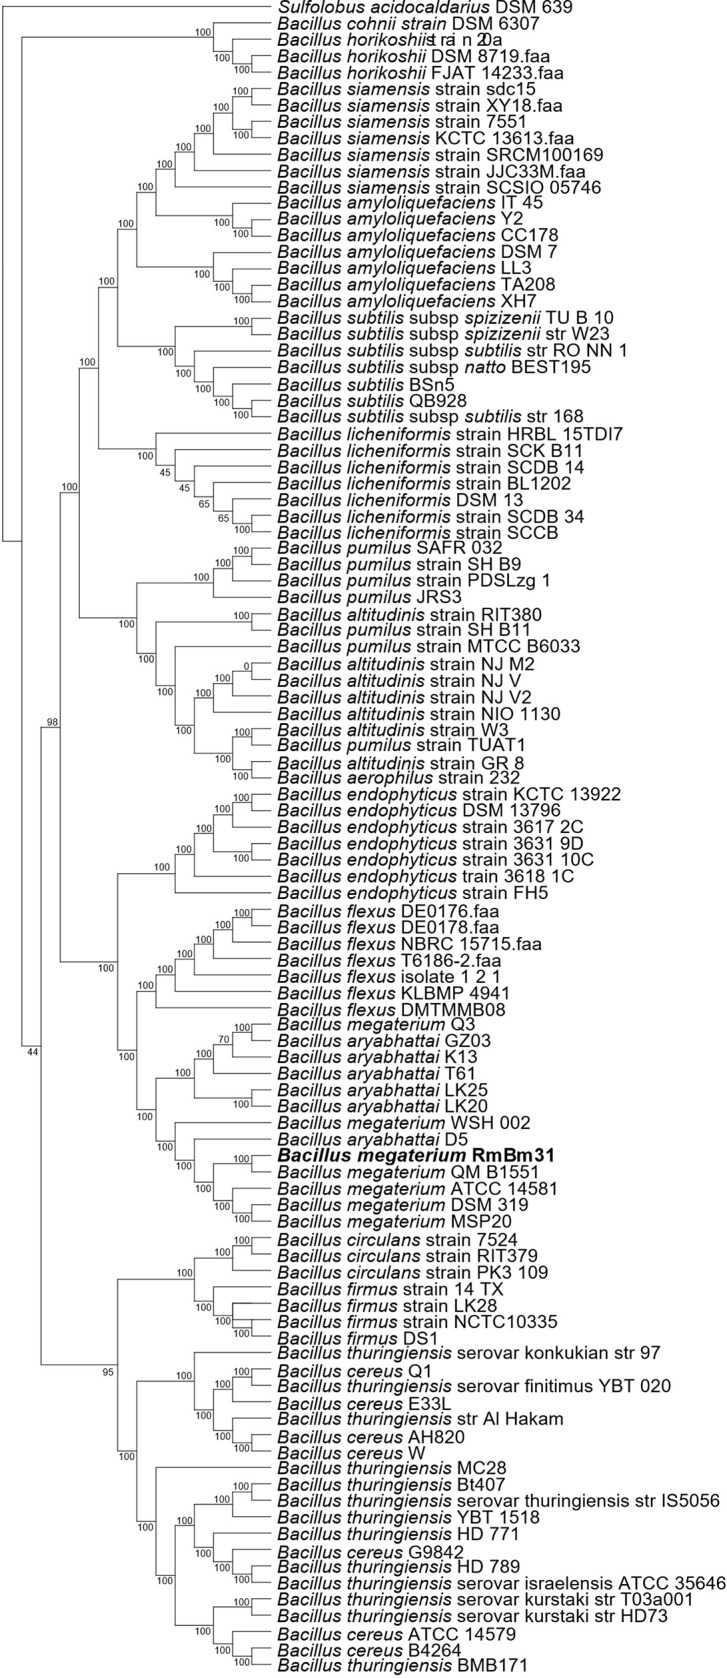
Phylogenomic tree based on 38 single copy genes obtained by the maximum-likelihood method showing the phylogenetic relationship of Bacillus megaterium RmBm31 with the related species. Orthofinder2 and IQ-tree were used to determine the position of Bacillus megaterium RmBm31 strain in relation to other species within the genus Bacillus. The tree was rooted with Sulfolobus acidocaldarius DSM639. The numbers above the branches are support values obtained from 1,000 bootstrap replicates.